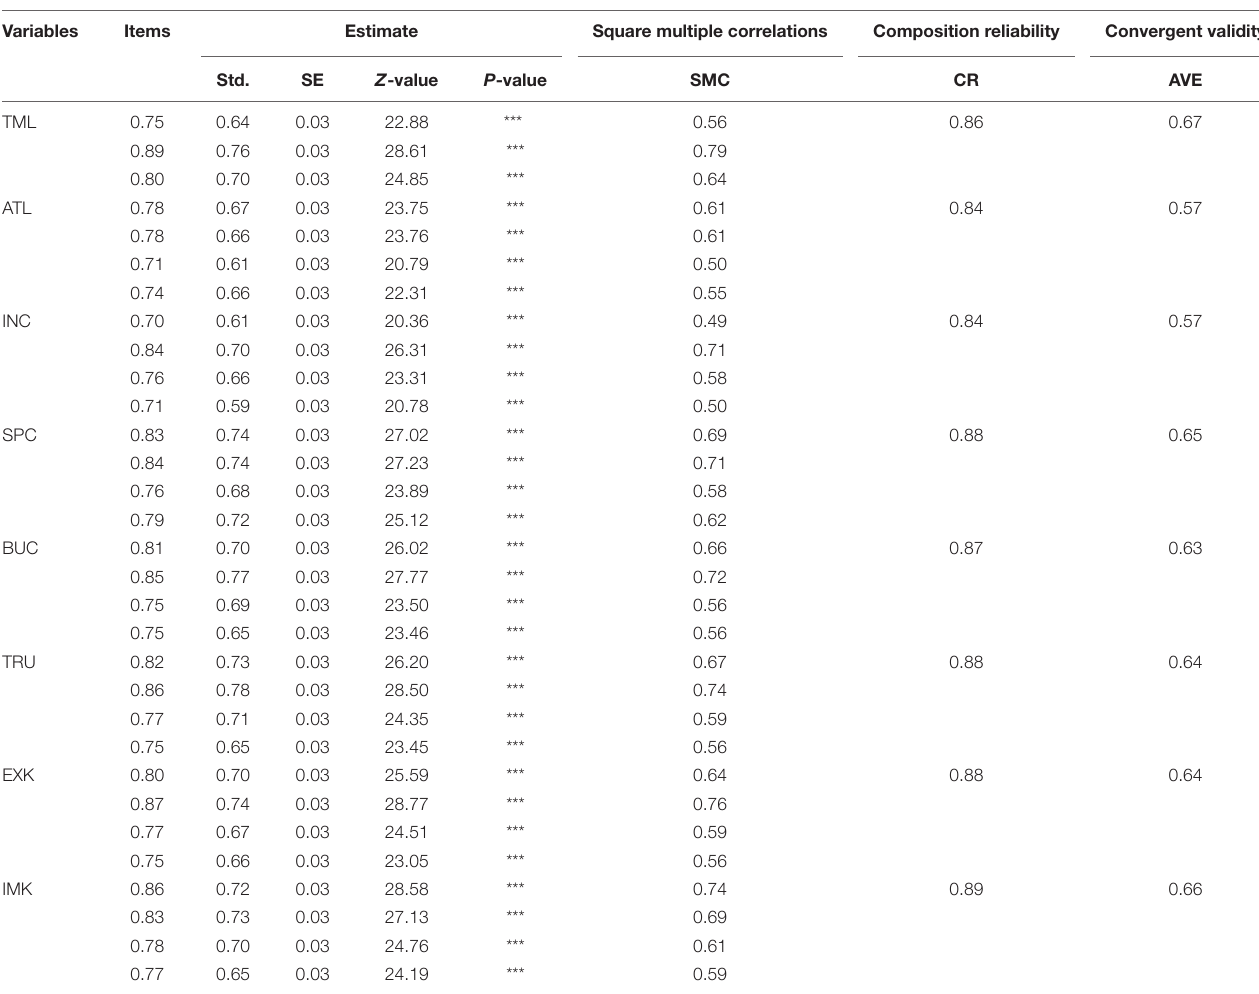
TABLE 2 | The composition reliability and convergent